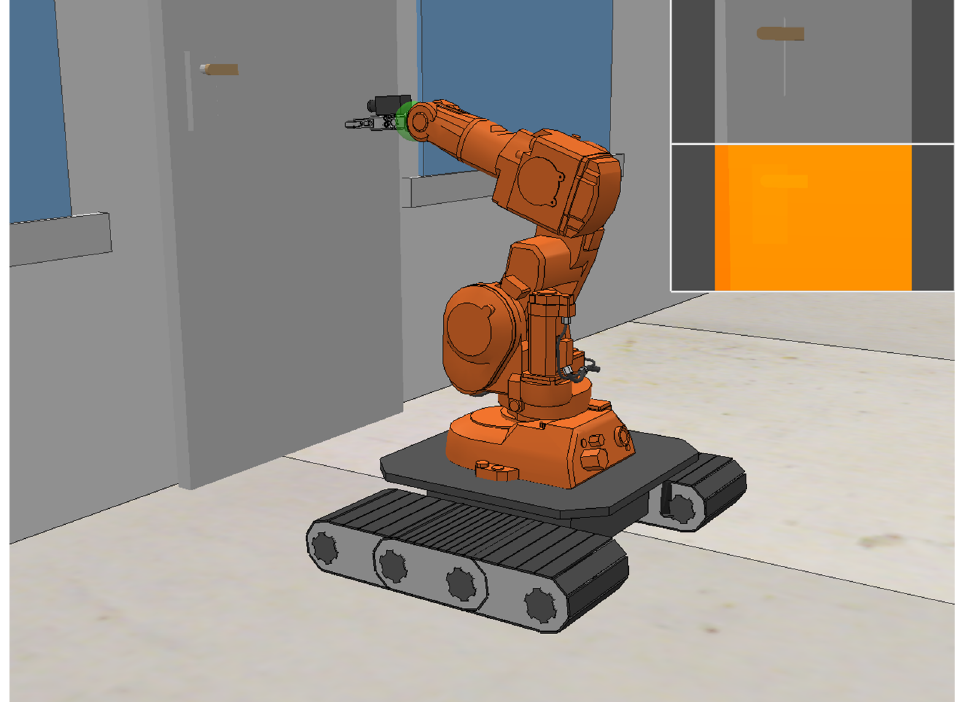
Figure 8. The simulation experiment platform.